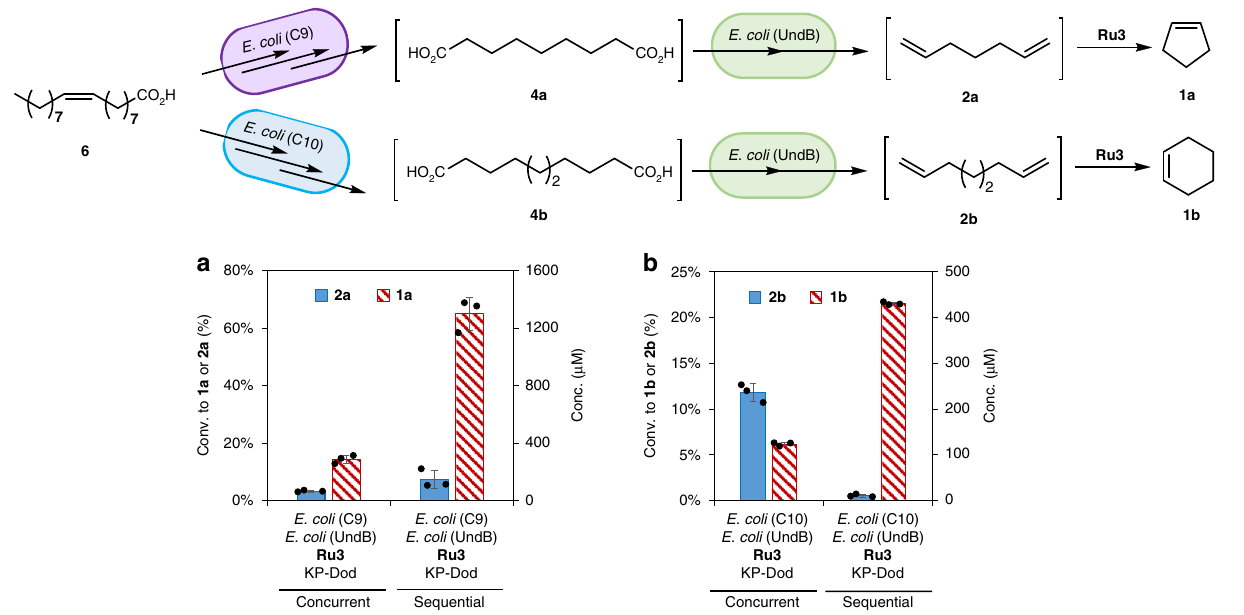
Fig. 7 Chemo-enzymatic cascades for the conversion of oleic acid to cyclopentene ( 1a ) and cyclohexene ( 1b ). a One-pot conversion of oleic acid ( 6 ) (2 mM) to cyclopentene ( 1a ) using E. coli (C9) (10 g l − 1 ), E. coli (UndB) (10 g l − 1 ) and Ru3 (100 μ M) in KP buffer (200 mM, pH 8.0, 1% glucose) with n - dodecane (10%) at 30 °C for 24 h. b One-pot conversion of oleic acid ( 6 ) (2 mM) to cyclohexene ( 1b ) using E. coli (C10) (10 g l − 1 ), E. coli (UndB) (10 g l − 1 ) and Ru3 (100 μ M) in KP buffer (200 mM, pH 8.0, 1% glucose) with n -dodecane (10%) at 30 °C for 24 h. For the sequential cascade, E. coli (UndB), Ru3 and n -dodecane were added after 12 h and the reaction was carried on for another 12 h (total 24 h). Source data are provided as a Source Data fi le. Data are mean values of triplicate experiments with error bars indicating standard deviations (n =